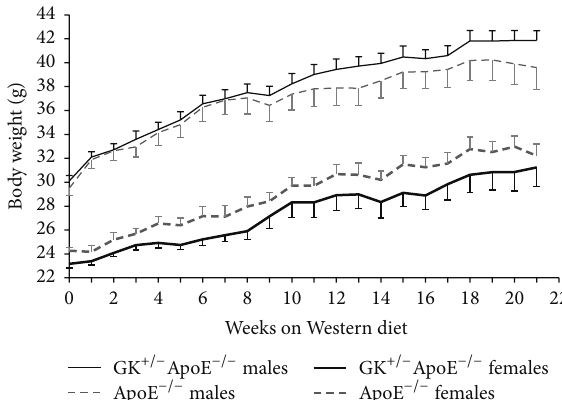
Figure 2: Body weight development of the GK +/− ApoE −/− mice compared with the ApoE −/− mice on WD. GK +/− ApoE −/− males have a higher body weight compared with the ApoE −/− males after 21 weeks on WD. ApoE −/− females have a higher body weight from baseline Chow diet and maintained the weight difference on WD compared with GK +/− ApoE −/− female mice. Values are presented as means and standard error of mean